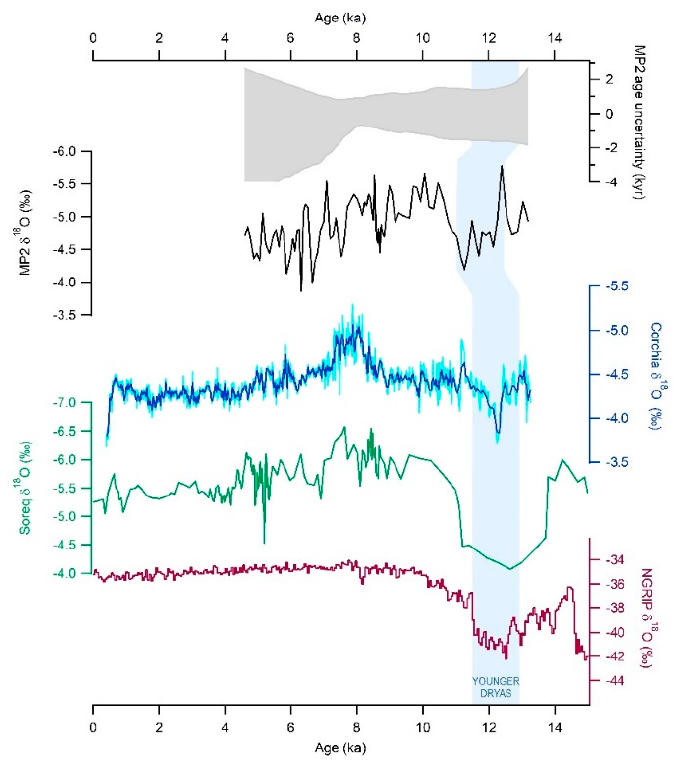
Figure 7. Comparison of the δ 18 O variation in the younger part of the MP-2 speleothem with other contemporaneous δ 18 O speleothem records from the Corchia [15] and Soreq caves [33] and with NGRIP δ 18 O data [2], with the prominent excursion ascribed to the Younger Dryas climatic event.